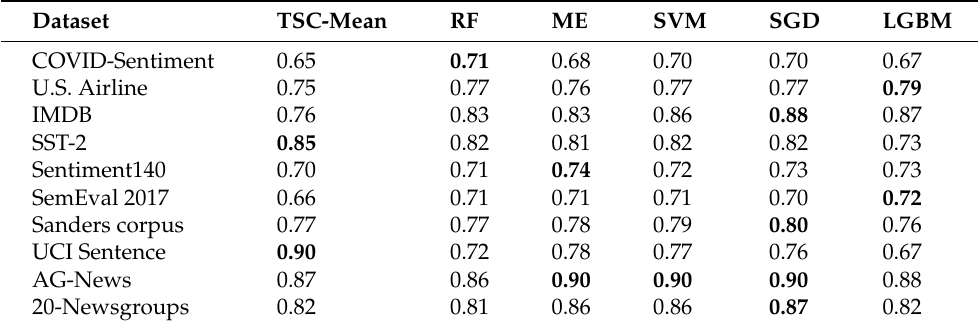
Table 9. SBERT vector-based AUC-ROC score for six classifiers. Best results are in bold face.